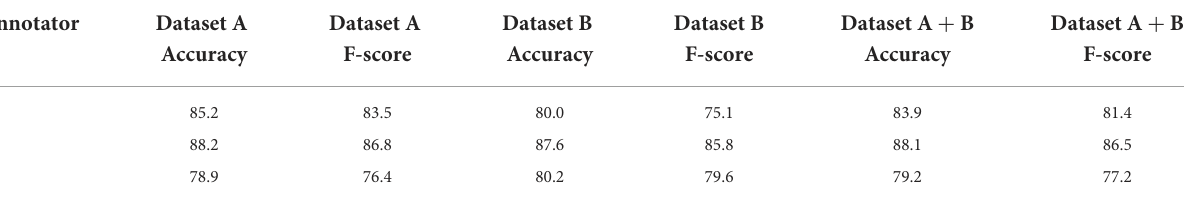
TABLE 3 Annotator accuracy and F-scores.